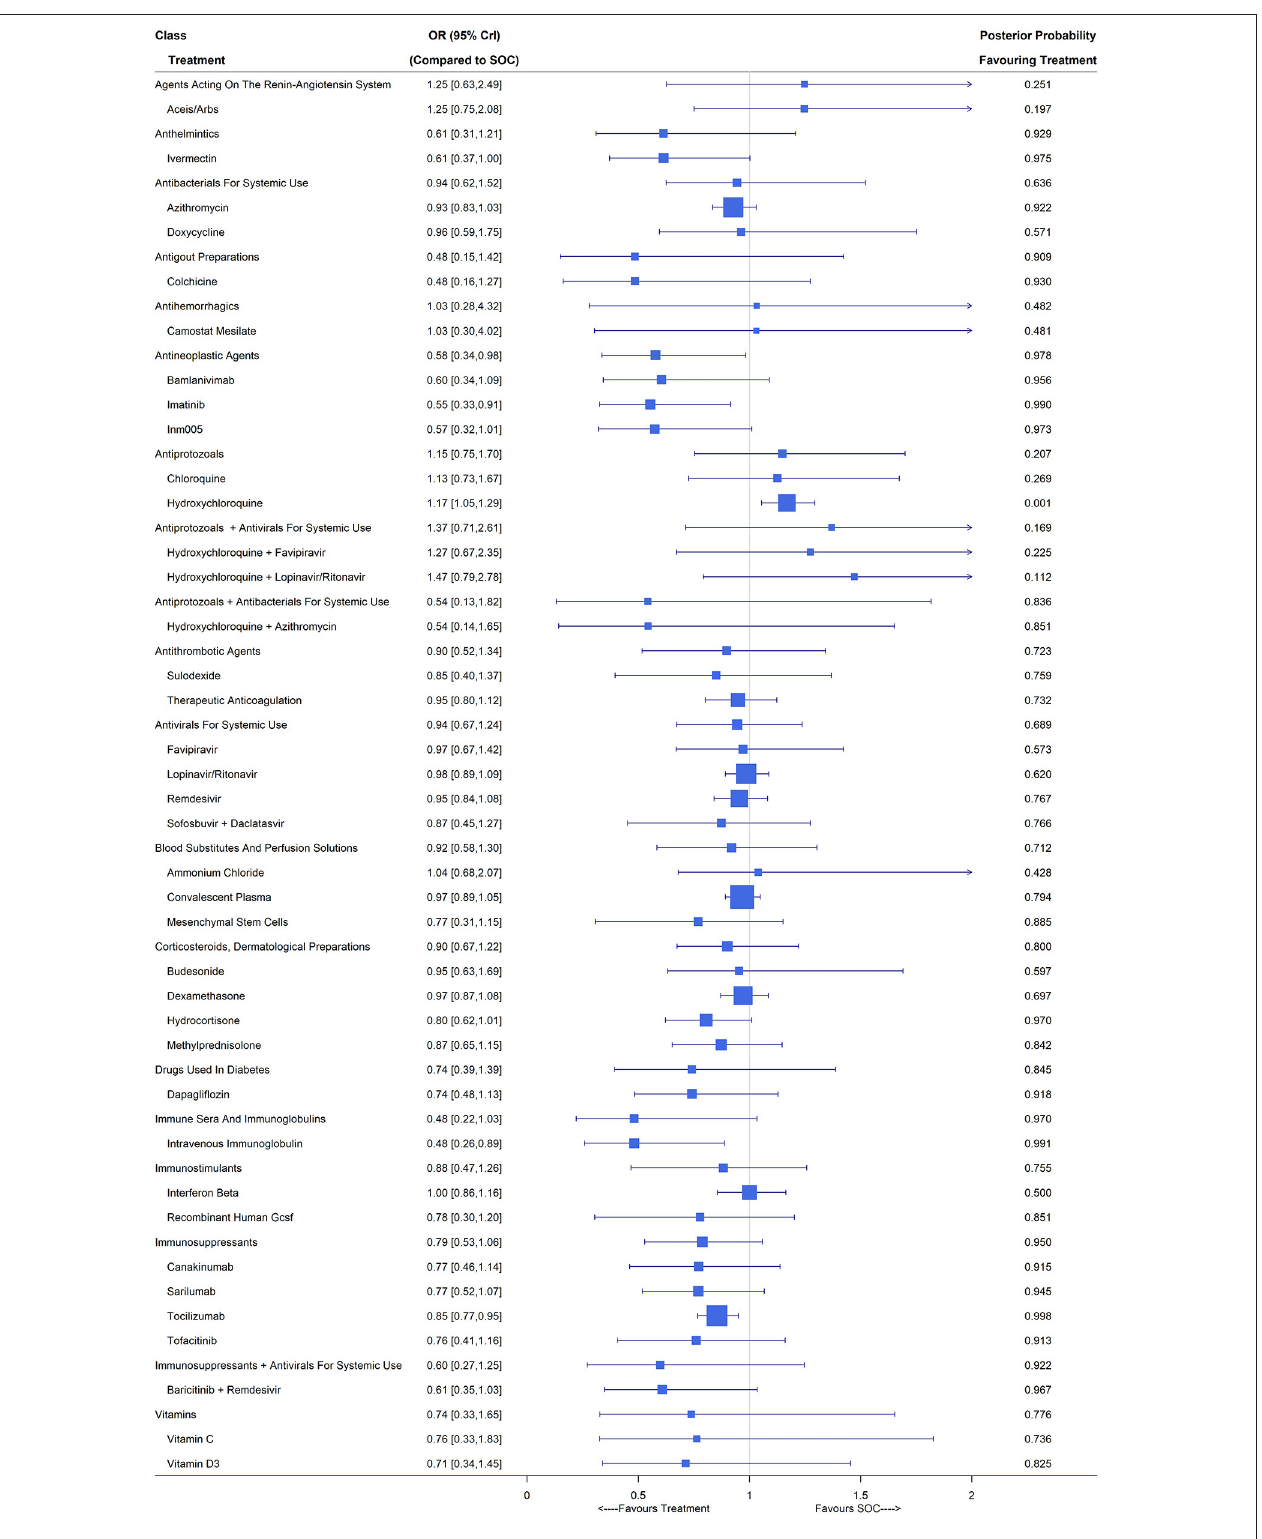
FIGURE 2 | Mortality under treatments compared with the standard of care (SOC); OR is the odds ratio and CrI represents the credible interval.